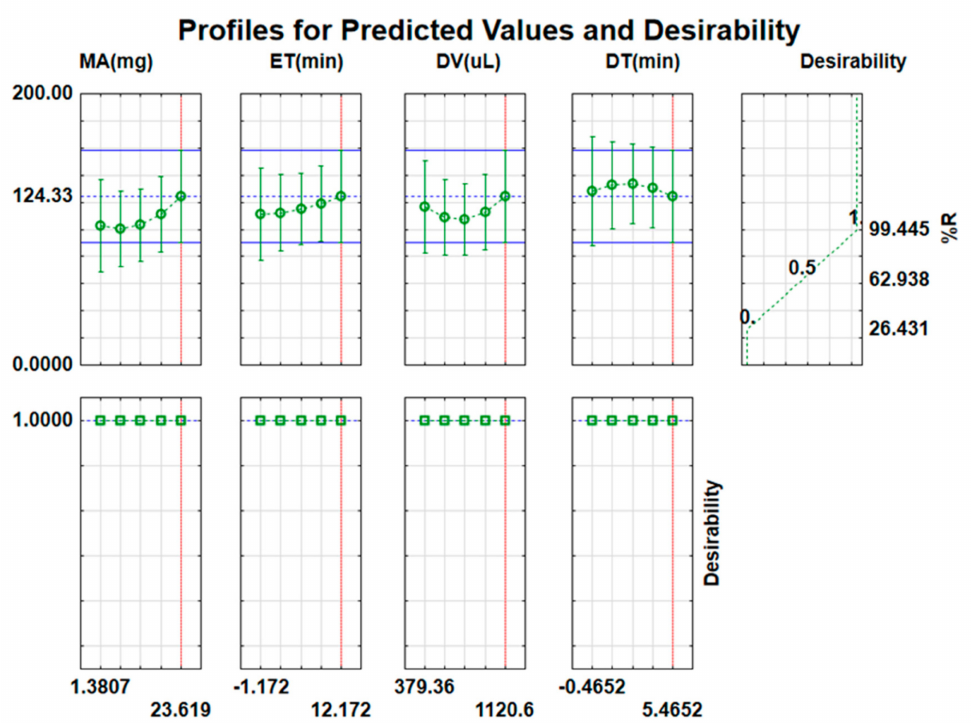
Figure 8. Desirability function profile for percentage recovery (%R) of ACT.